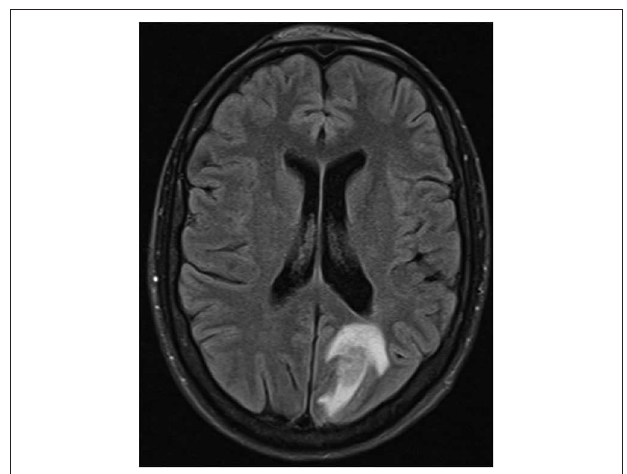
FIGURE 1 | Hyperintense lesion with perifocal edema left occipital in fluid-suppressed T2 MRI technique (Fluid-attenuated inversion recovery (FLAIR)